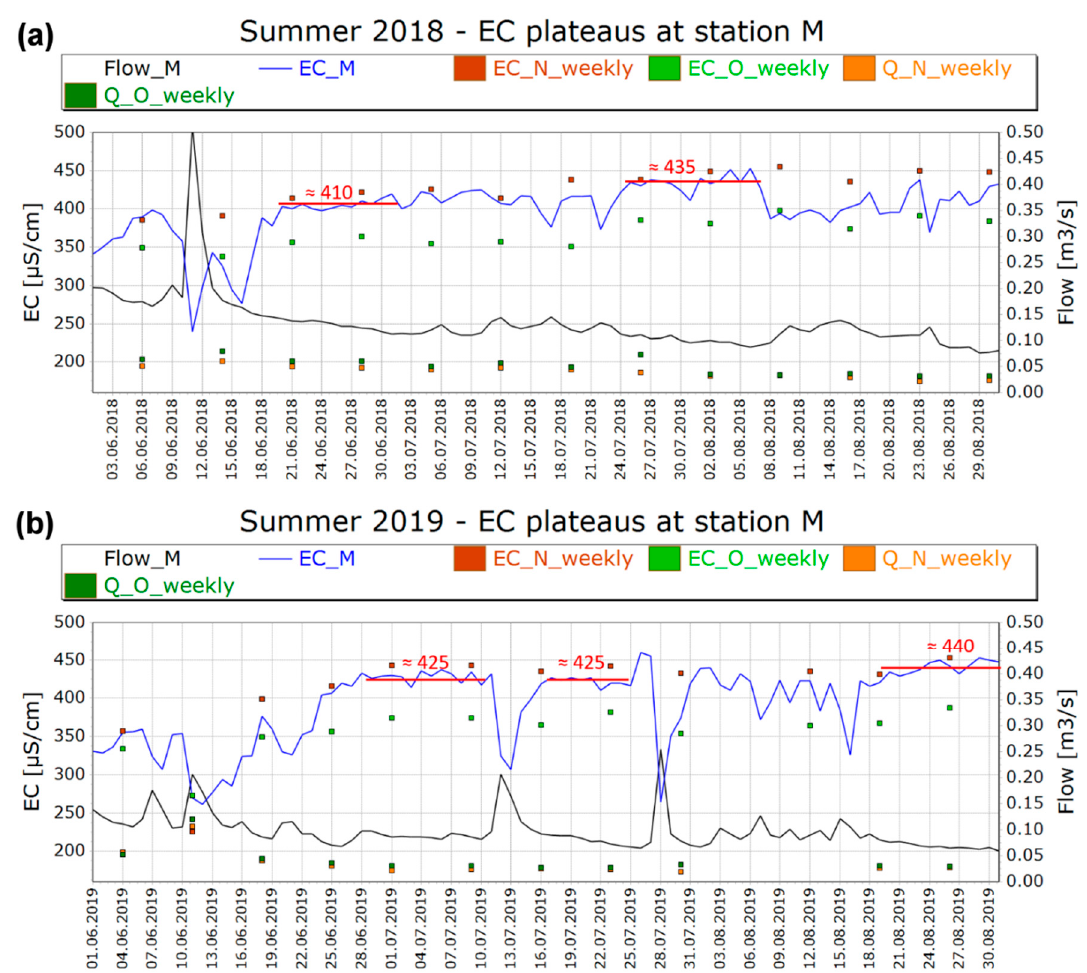
Figure 11. Estimation of EC baseflow in the summer of ( a ) 2018 and ( b ) 2019 at station M, complemented by the derivation of the EC plateaus. Daily mean flow data acquired from the HLNUG [33].